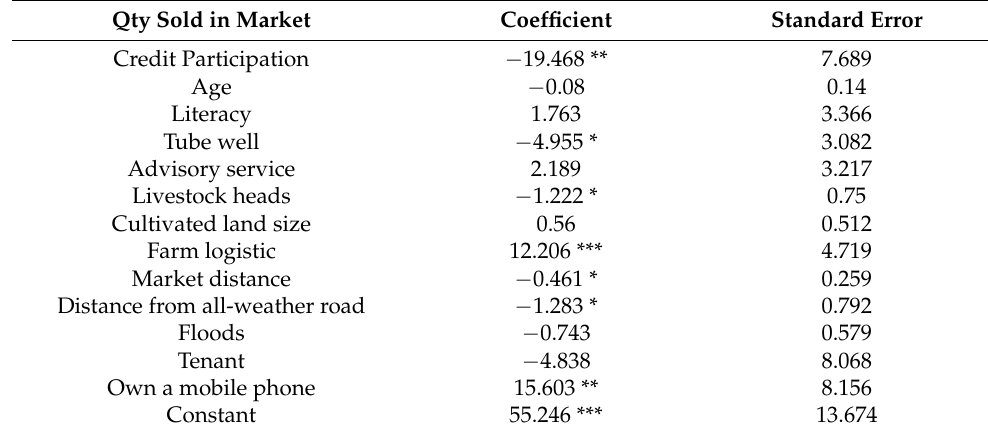
Table A4. Full table of IV estimate of first-period credit and market